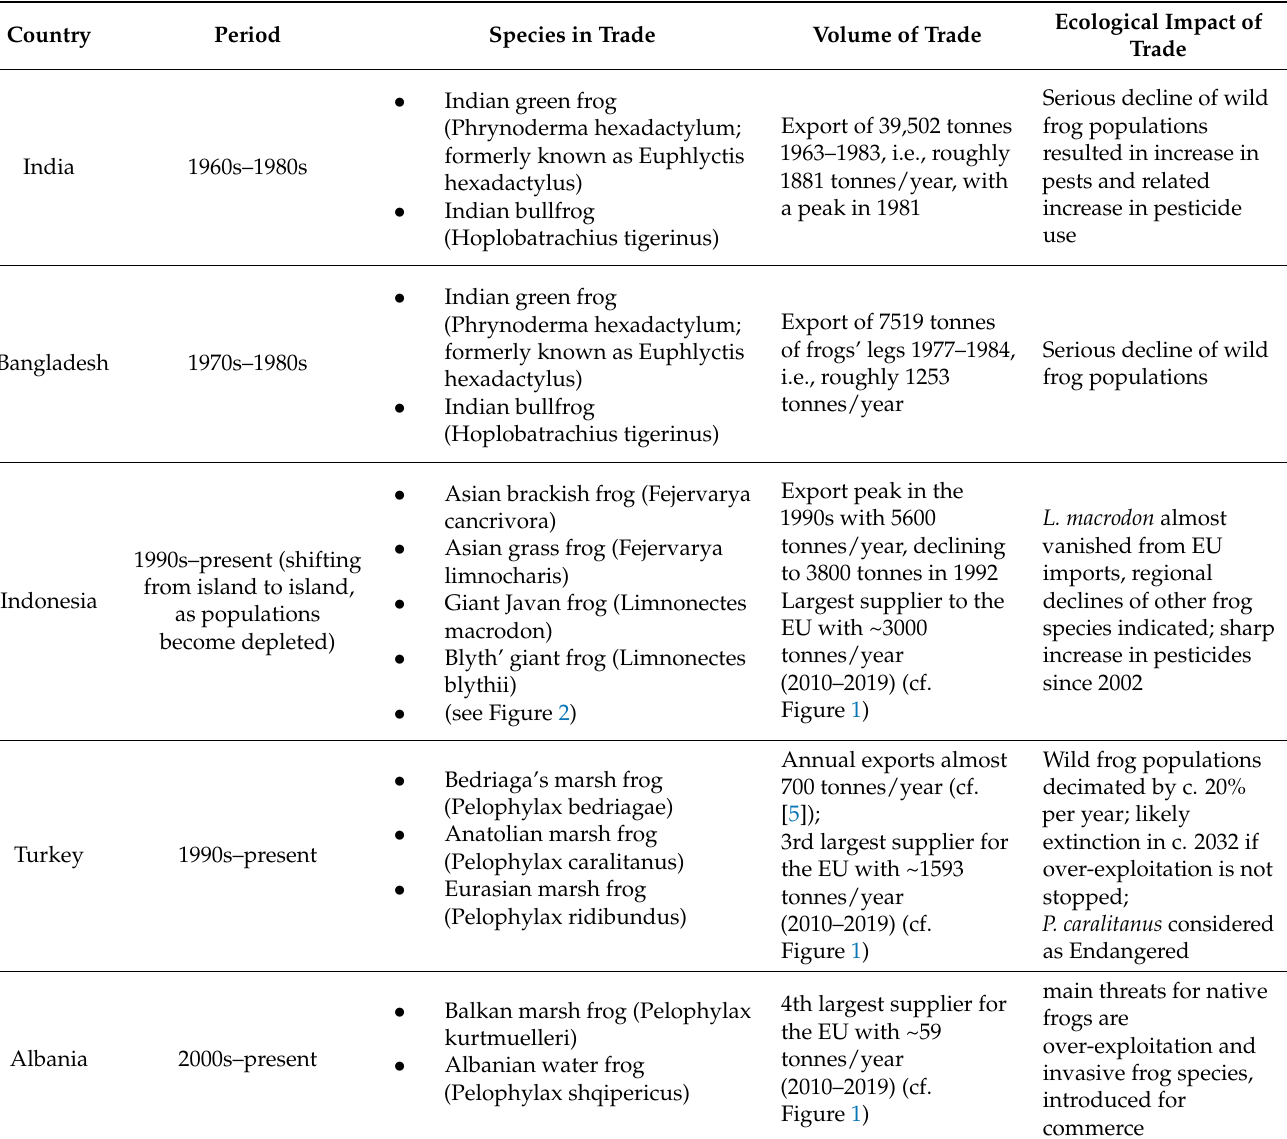
Table 1. Historical and current characteristics of the global frog’s legs trade (for details see [3,4]). Species in Trade Volume of Trade